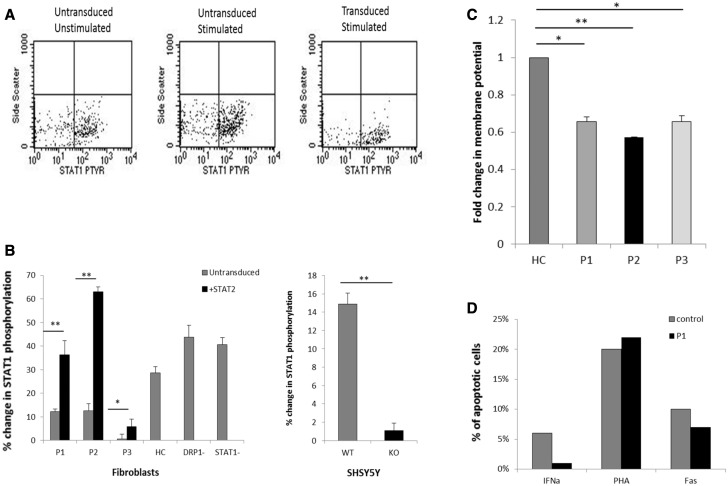

STAT1 phosphorylation before and after stimulation with IFNα, membrane potential and apoptosis levels. (A) Representative FACS dot blot graph showing phosphorylated STAT1 in STAT2 transduced cells compared to non-transduced STAT2 deficient cells after stimulation (results for Patient 3 shown). (B) The percentage change in phosphorylated cells was calculated from the data from A [patient cells, transduced cells and SHSY5 wild-type (WT) and STAT2 knockout (KO) cells]. Data represents the mean ± SD (n = 3). *P < 0.05, **P < 0.005 (C) Membrane potential analysis in control and patient cells using TMRM staining. The mean fluorescence intensity was analysed via confocal microscopy and Image J (n = 3;>27 cells analysed for each n, ± SEM) *P < 0.05, **P < 0.005. (D) Apoptosis was analysed in fibroblasts derived from the STAT2 deficient patient (Patient 1) and compared to fibroblasts derived from healthy individuals. Cultured fibroblasts were left unstimulated or stimulated with 100 U/ml IFNα, 10 µg/ml anti-fasL IgM or phytohaemagglutinin. Cells were analysed using CellQuest Pro and the percentage of apoptotic cells defined as annexin V+7AAD+.